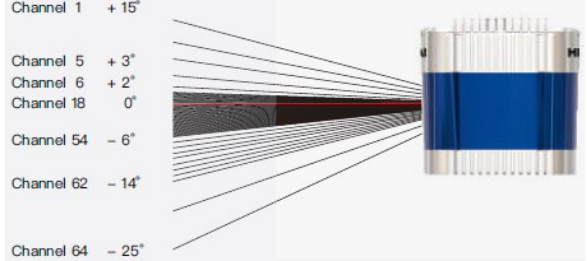
Figure 2 . MBL channel distribution (Hesaitech, 2021)